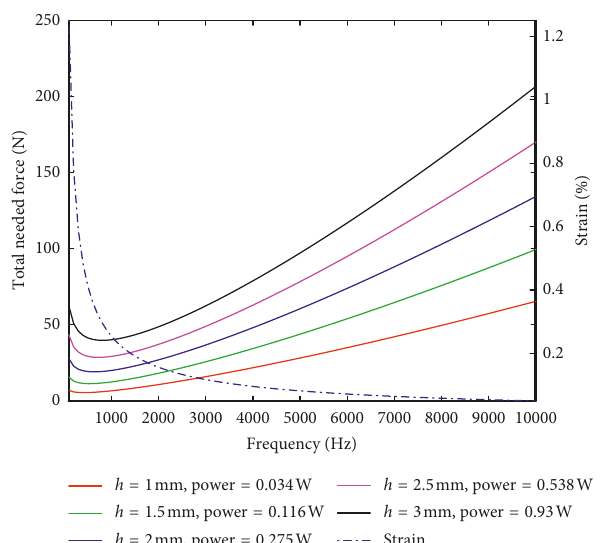
Figure 9: Total force needed at different frequencies.